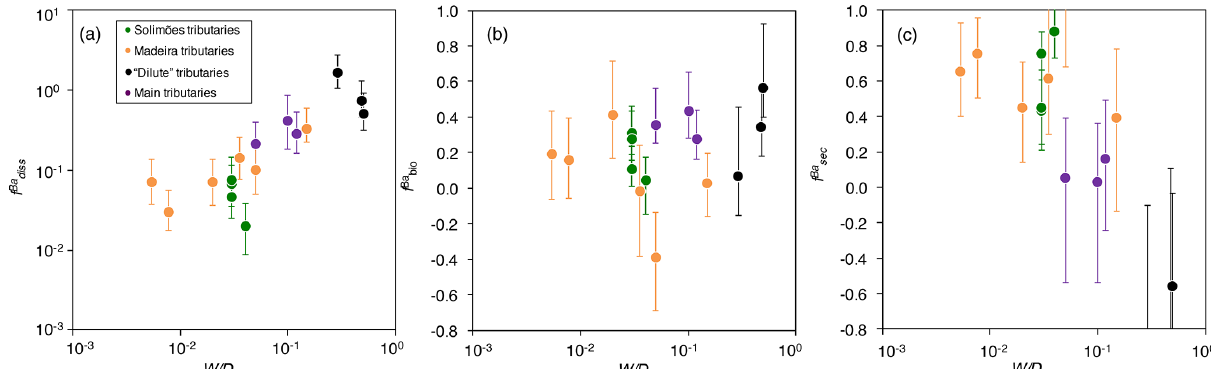
Figure 4. The distribution of Ba amongst different compartments of the Critical Zone ( f Ba ) for (a) dissolved export ( diss ) , (b) biota ( bio; i Eq. 8), and (c) secondary weathering products such as clays or oxides ( sec ) , once released from rocks vs. W/D (weathering intensity), in the Amazon Basin. W/D values are taken from Wittmann et al. (2011) and Dellinger et al. (2015b). In panel ( c ), f Ba sec is calculated − f Ba (Eq. 6). Uncertainties on f Ba have been evaluated using Monte Carlo error propagation based on the uncertainties on as 1 − f Ba i diss bio individual parameters (Appendix B; Table S2). Note the logarithmic scale used for f Ba in panel (a) . diss